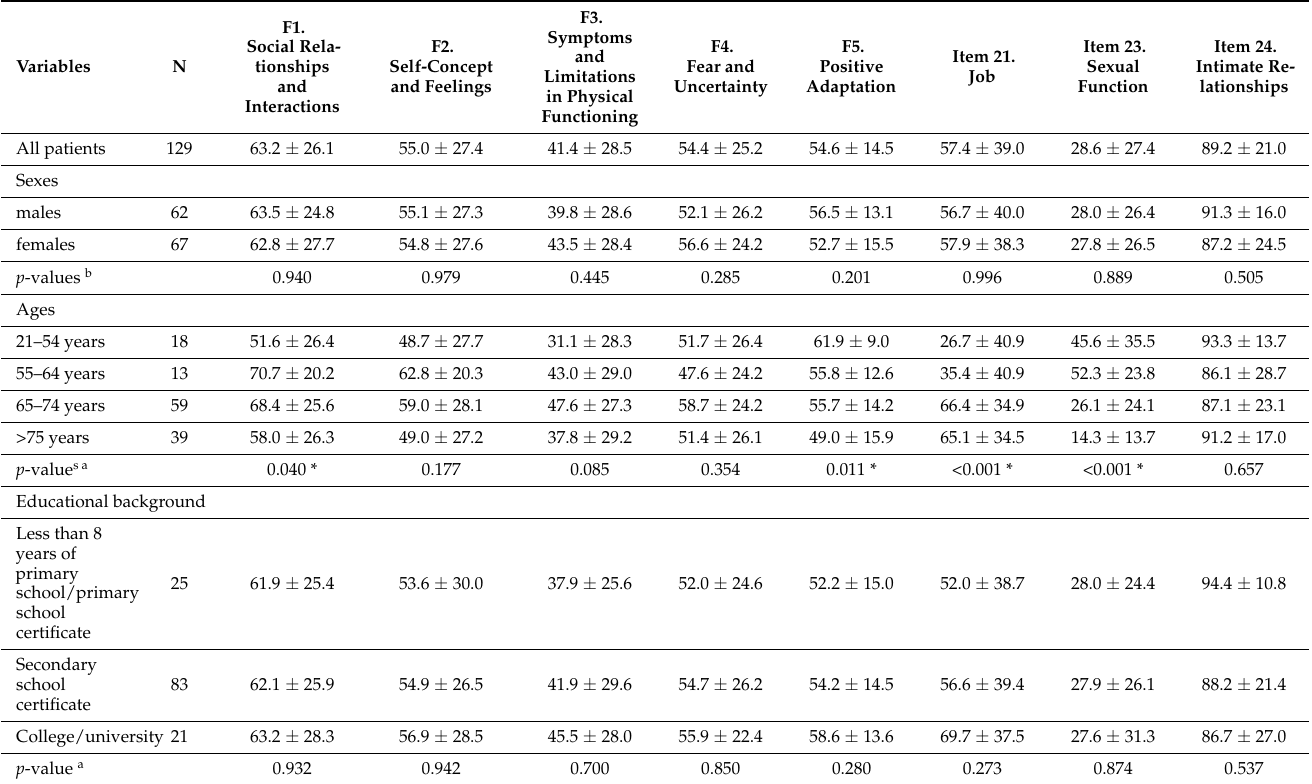
Table 6. Correlation between the mean values of the PADQoL factors with the sociodemographic data. Legend: * Asterisked data indicate statistically significant results.